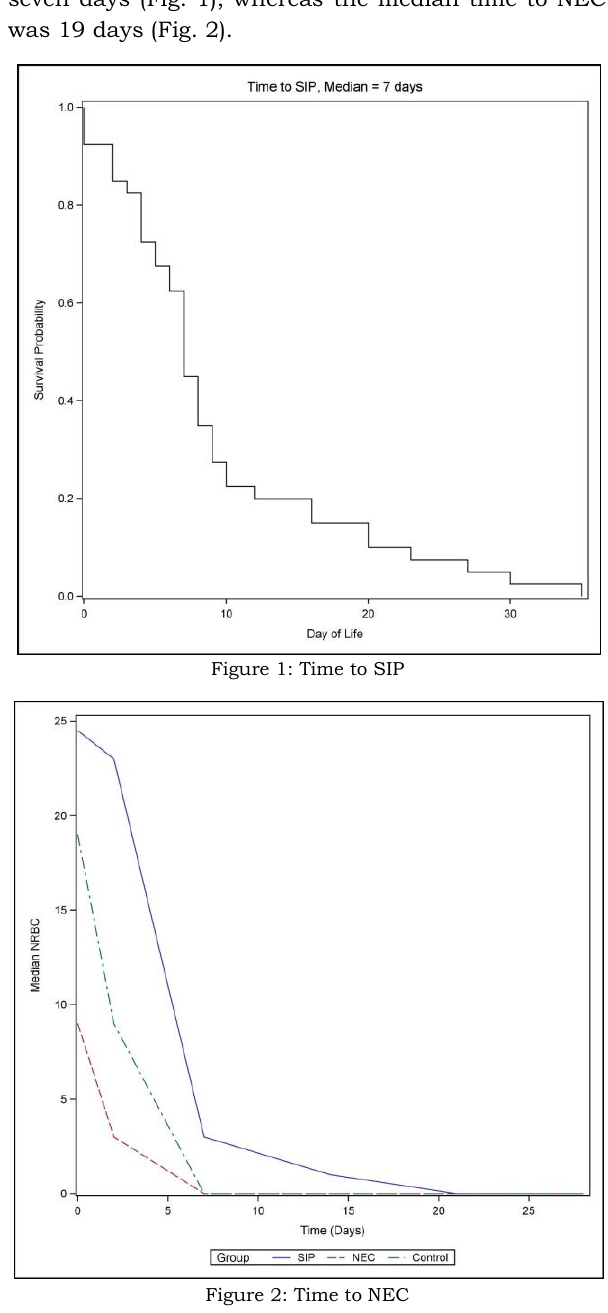
Figure 2: Time to NEC